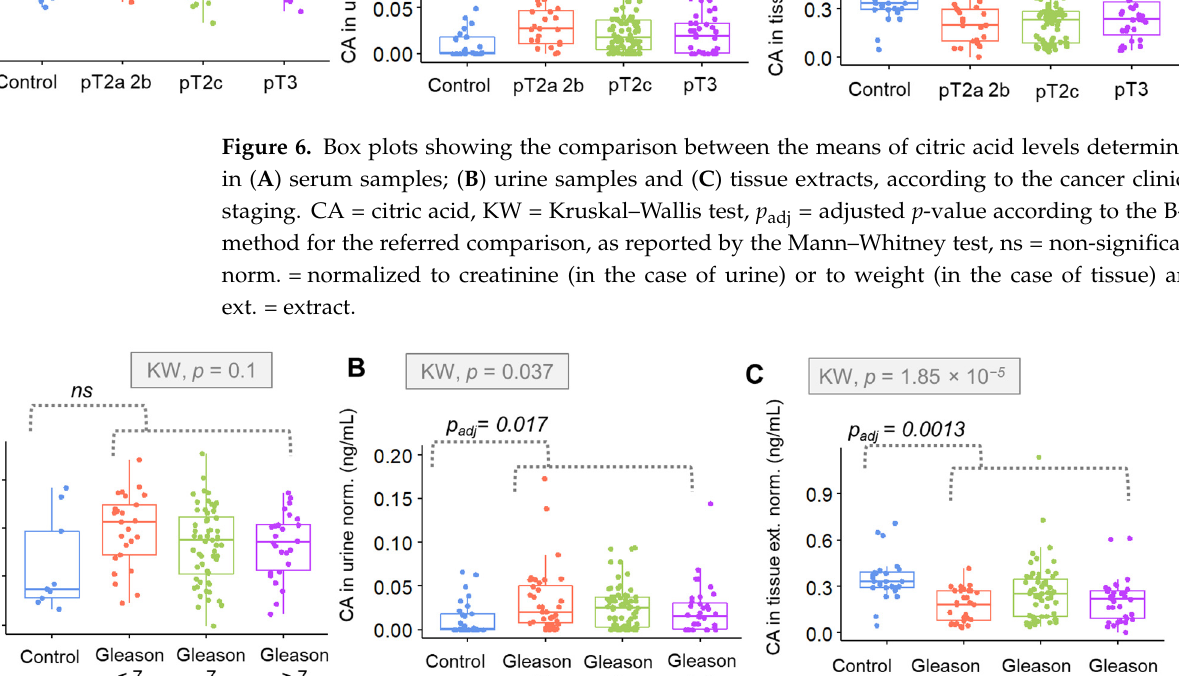
Figure 7. Box plots showing the comparison between the means of citric acid levels determined in ( A ) serum samples; ( B ) urine samples and ( C ) tissue extracts, according to the GS. CA = citric acid, KW = Kruskal–Wallis test, p adj = adjusted p -value according to B-H method for the referred comparison, as reported by the Mann–Whitney test, ns = non-significant, norm. = normalized to creatinine (in the case of urine) or to weight (in the case of tissue) and ext. =